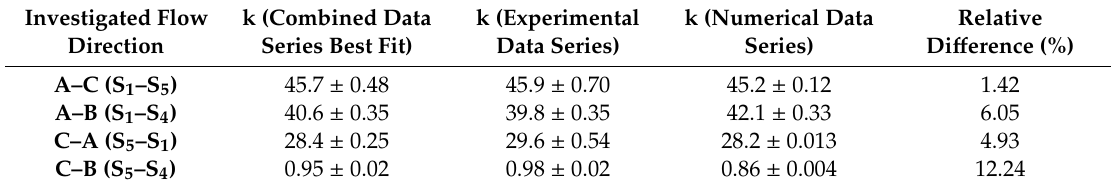
Table 2. Experimental, numerical (ANSYS-CFX), and combined best linear fit head loss coefficients.